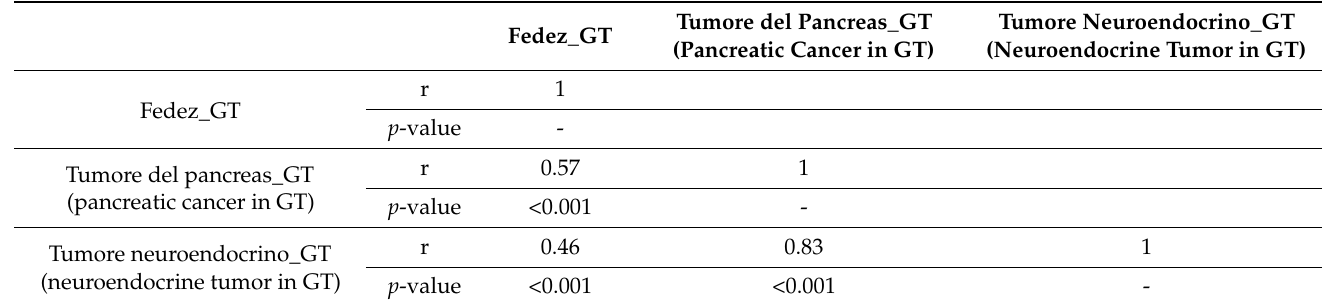
Table 1. Pearson’s correlation coefficient (r) for Google Trends search terms in Italy from January 2004 to November